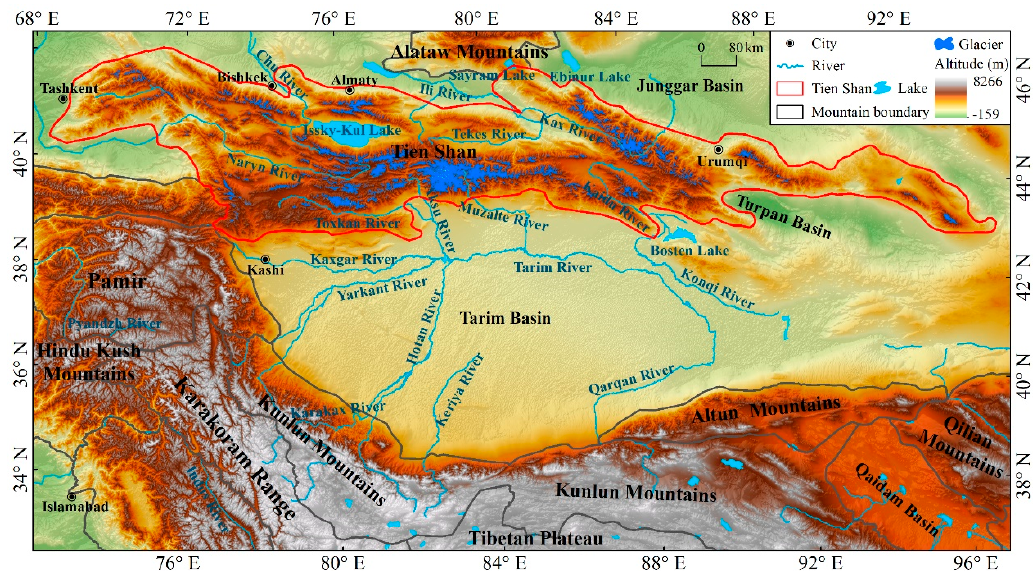
Figure 1. Digital elevation model (ASTER GDEM V2) of the study area shows elevation of the Tien Shan Range spanning from northern Xinjiang, China to parts of Kazakhstan, Kyrgyzstan, and Uzbekistan (political boundaries are not shown) and the Tarim Basin and surrounding mountain ranges.